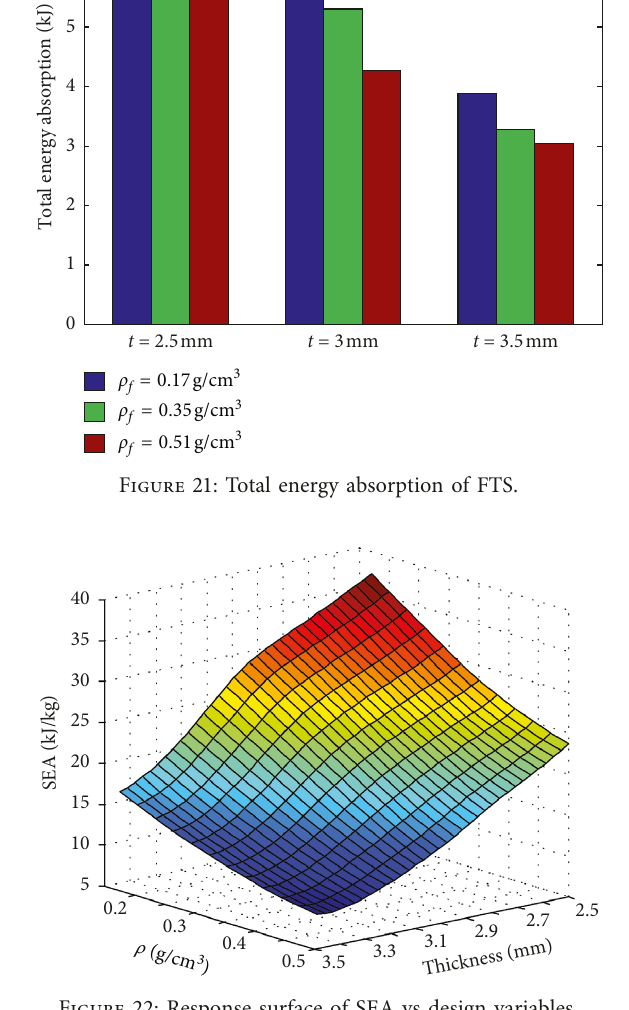
Figure 22: Response surface of SEA vs design